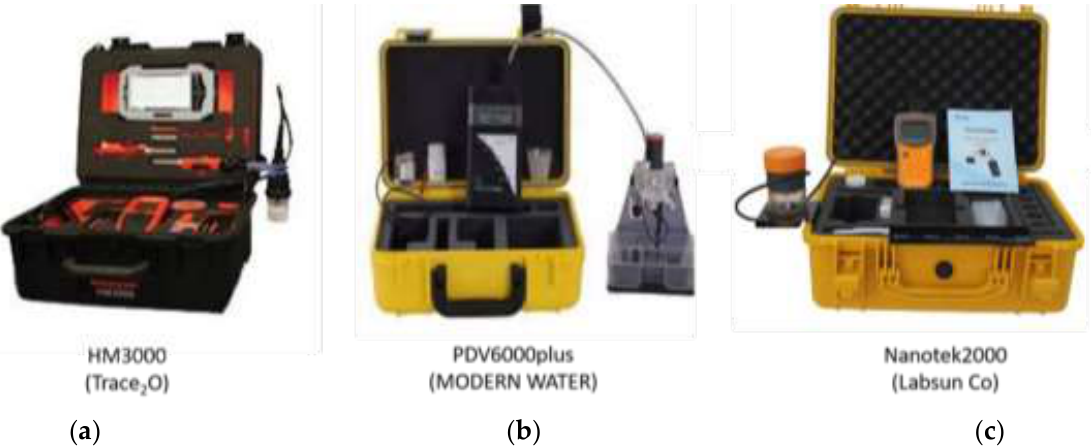
Figure 2. Available toxic metal analysers for on-site monitoring: ( a ) HM3000 form Trace 2 O, Berkshire, United Kingdom; ( b ) PDV6000 plus from MODERN WATER, London, United Kingdom; ( c ) Nanotek2000 from Lubsun Co, Shaanxi,